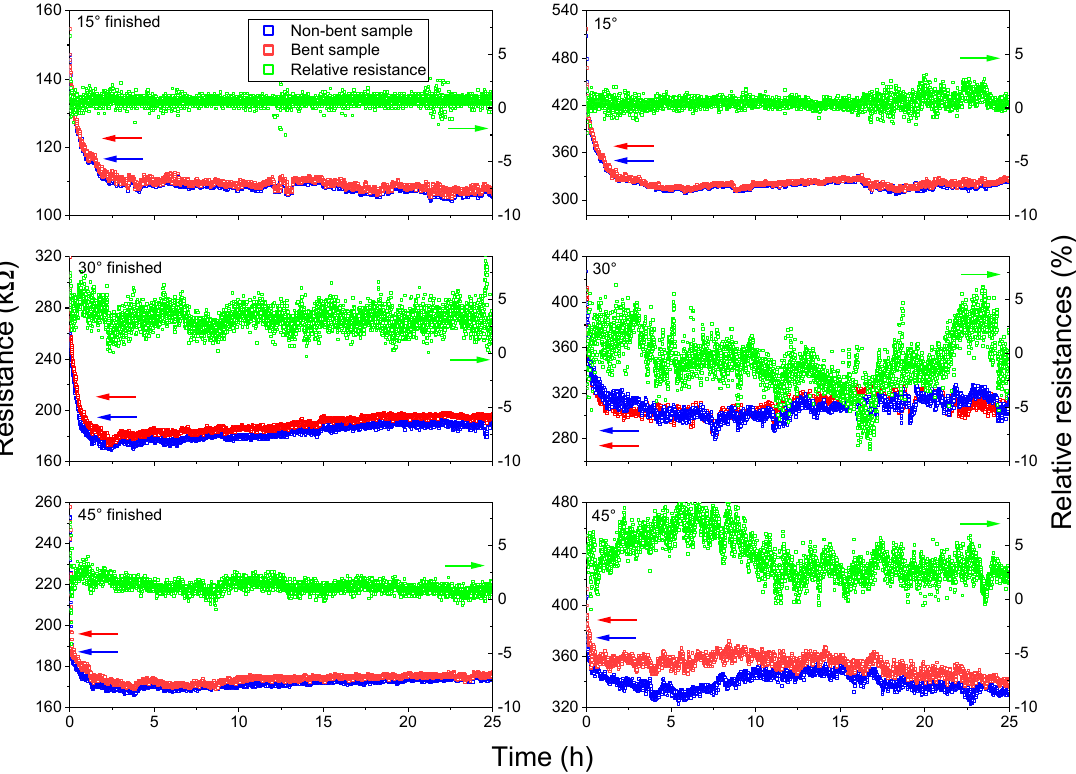
Figure 8. Cyclic bending of the leathers coated by polypyrrole synthesized in presence of PVP and crystal violet. Time dependence of resistance measured during 5000 cycles on finished ( left ) and non-finished, i.e., reverse, ( right ) sides at angles 15° ( top ), 30° ( middle ), and 45° ( bottom ). Original position (blue), bent sample (red), and relative resistances (green).